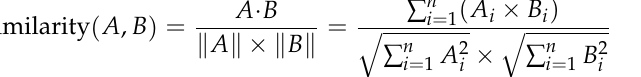
Figure 4. Unlike the convolution mode of 2D images, RGB information is taken as the input parameter of the image matrix and the image matrix of fixed size is limited by the